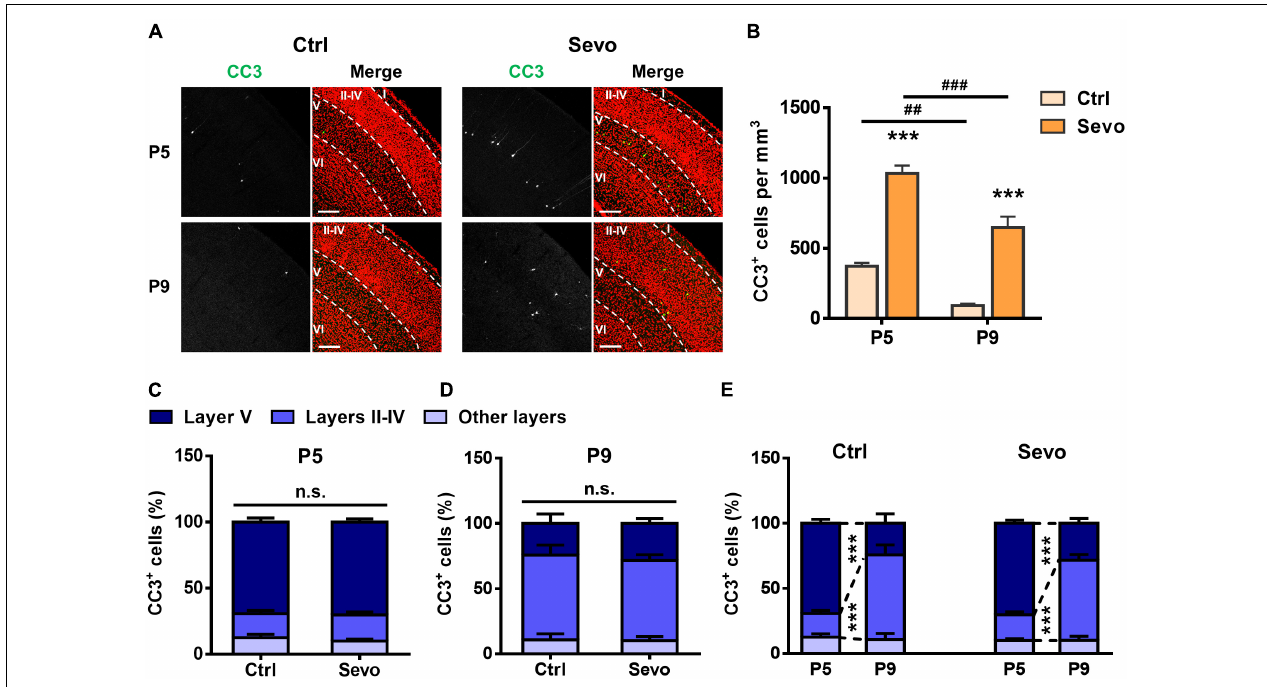
FIGURE 1 | During development, sevoflurane-induced apoptosis follows a lamination pattern similar to that of physiological apoptosis. (A) Representative confocal images of coronal primary somatosensory cortex (S1) sections immunolabelled for cleaved caspase-3 (CC3; green) and co-stained for nuclei with TOPRO (red) to visualize cortical lamination. Age and treatment conditions are as indicated. Cortical layers are indicated by Roman numerals, and borders between cortical layers marked using dotted lines. The scale bar is 200 µ m. (B) Quantitation of the number of CC3 + cells per mm 3 in the S1. Age and treatment conditions are as indicated. * , sevoflurane group compared to control group of the same age; # , P5 compared to P9 of each treatment condition; *** , P < 0.001; ## , P < 0.01; ### , P < 0.001, using two-way analysis of variance (ANOVA) followed by Bonferroni post hoc tests. (C,D) Distribution of the proportion of CC3 + cells in different cortical layers at P5 (C) and P9 (D). In each age group, the percentage of CC3 + cells in layers II–IV, layer V, or other layers (layer I and layer VI) in the sevoflurane group is not significantly different from that of the control group; P > 0.05 by two-way ANOVA followed by Bonferroni post hoc tests. (E) Replot of the data presented in panels (C,D) for the control and sevoflurane groups, showing developmental changes in the apoptosis pattern. *** , P < 0.001 by two-way ANOVA followed by Bonferroni post hoc tests. Three mice were used per condition, and 10 brain slices from each mouse were quantitated. Data are shown as the mean ± standard error of mean.